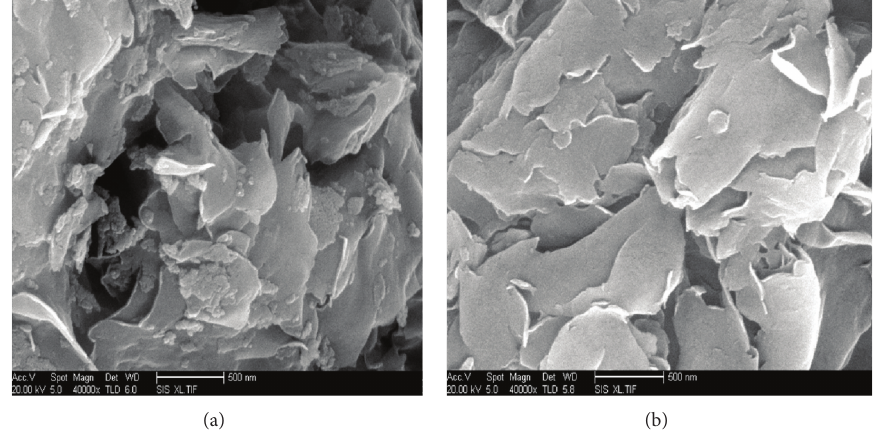
Figure 2: The SEM photographs of OMMT.